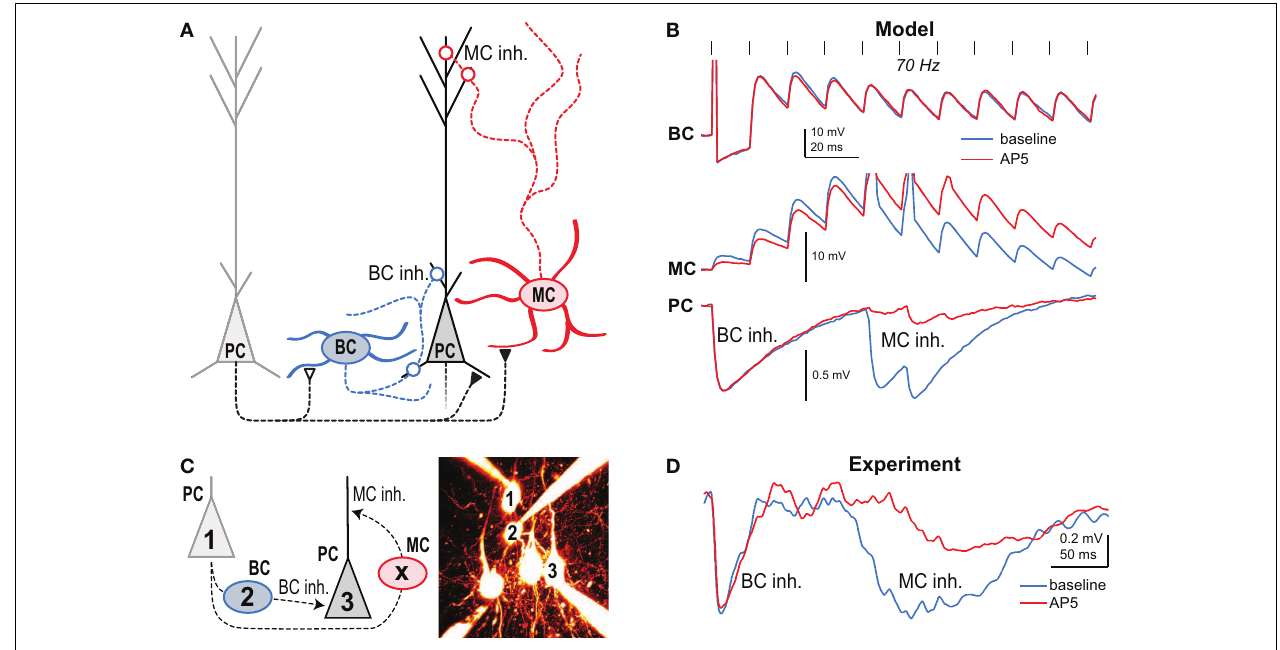
FIGURE 3 | Presynaptic NMDARs reroute spiking in neocortical microcircuits. (A) Presynaptic NMDARs are specifically expressed at PC-PC and PC-MC synapses (closed symbols), but not at the other connections (open symbols). Circles denote inhibitory synapses. (B) A network model with tuned synaptic dynamics predicted that during 70-Hz presynaptic PC firing (vertical lines) blockade of preNMDARs would affect late MC but not early BC inhibition. Traces indicate the model’s prediction of synaptic dynamics before (blue) and after (red)